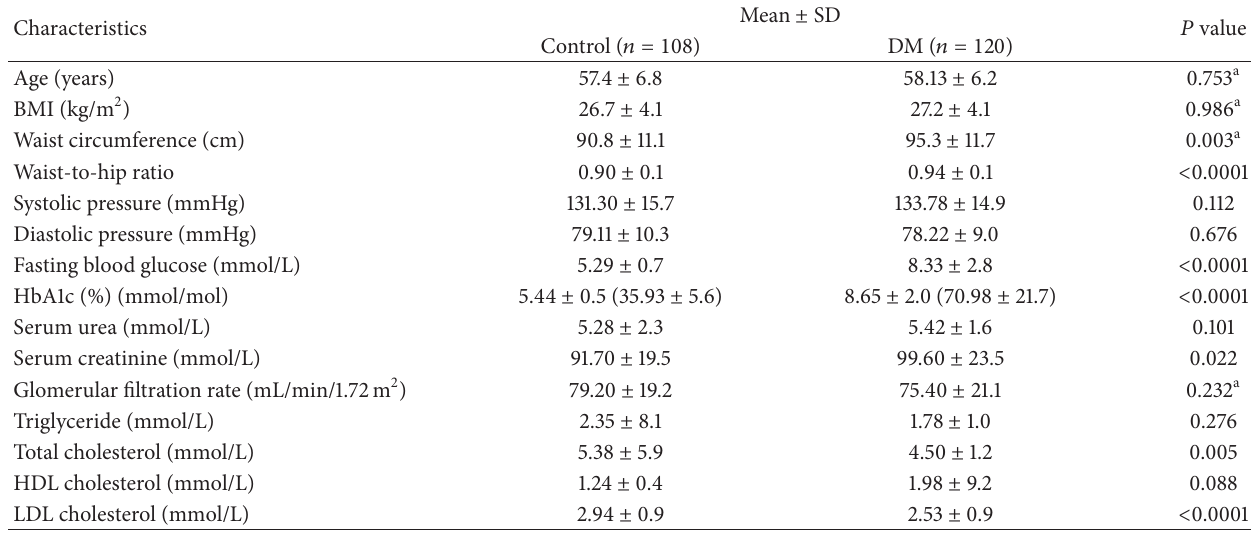
Table 2: Demographic and clinical data of male